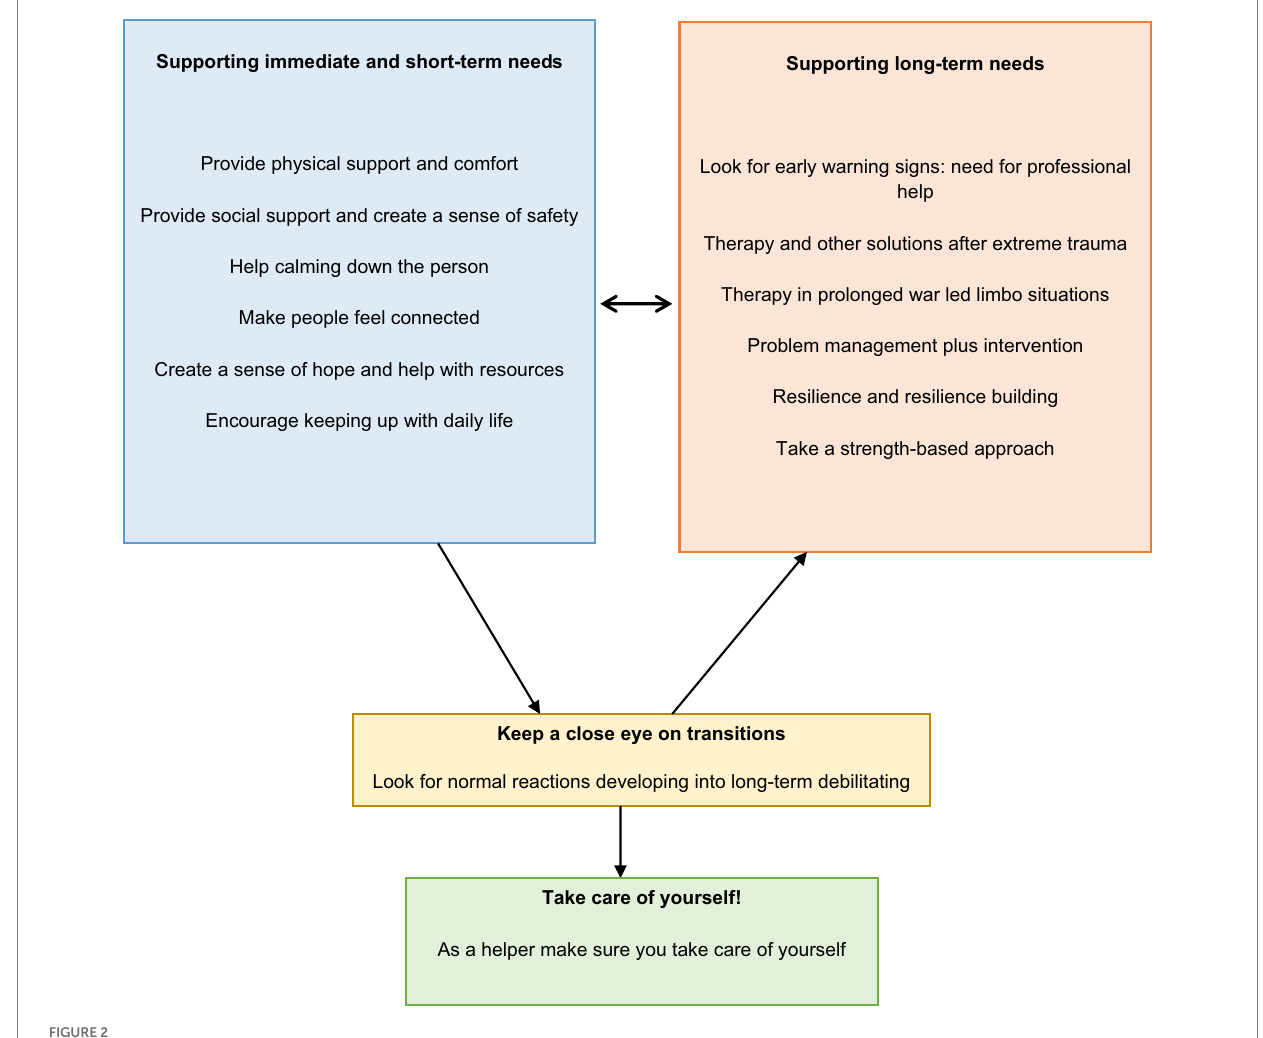
FIGURE 2 How to be helpful: Practical guide for working with civilians, asylum seekers and refugees of war